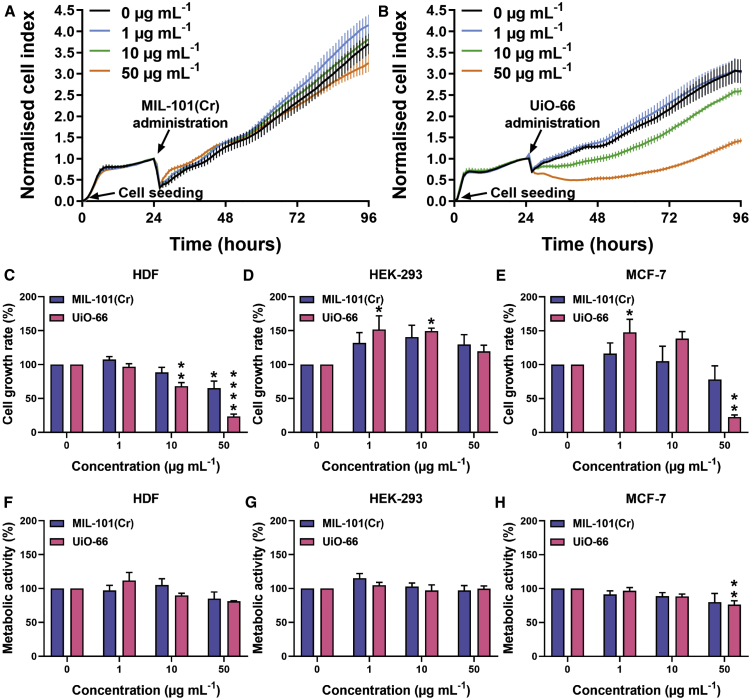
Biocompatibility Assessment of MOFs(A and B) Real-time cell analysis (RTCA) screening of (A) MIL-101(Cr) and (B) UiO-66 in HDFs. Cells were seeded at 0 h and MOFs were administered at 24 h. Cell growth was then monitored until 96 h. The data are presented as means ± SDs (n = 6).(C–E) The cell proliferative capacity was assessed by slope analysis of RTCA data from 24 to 96 h for (C) HDF, (D) HEK-293, and (E) MCF-7 cells. The data are presented as means ± SEMs. One-way ANOVA with Dunnett’s test (n = 3).(F–H) Direct comparison with cell metabolic activity, evaluated with Alamar blue assay, for (F) HDF, (G) HEK-293, and (H) MCF-7 cells, 72 h post-MOFs administration. Data are presented as means ± SEMs; One-way ANOVA with Dunnett’s test (n = 3).∗p ≤ 0.05, ∗∗p ≤ 0.01, ∗∗∗p ≤ 0.001, and ∗∗∗∗p ≤ 0.0001.